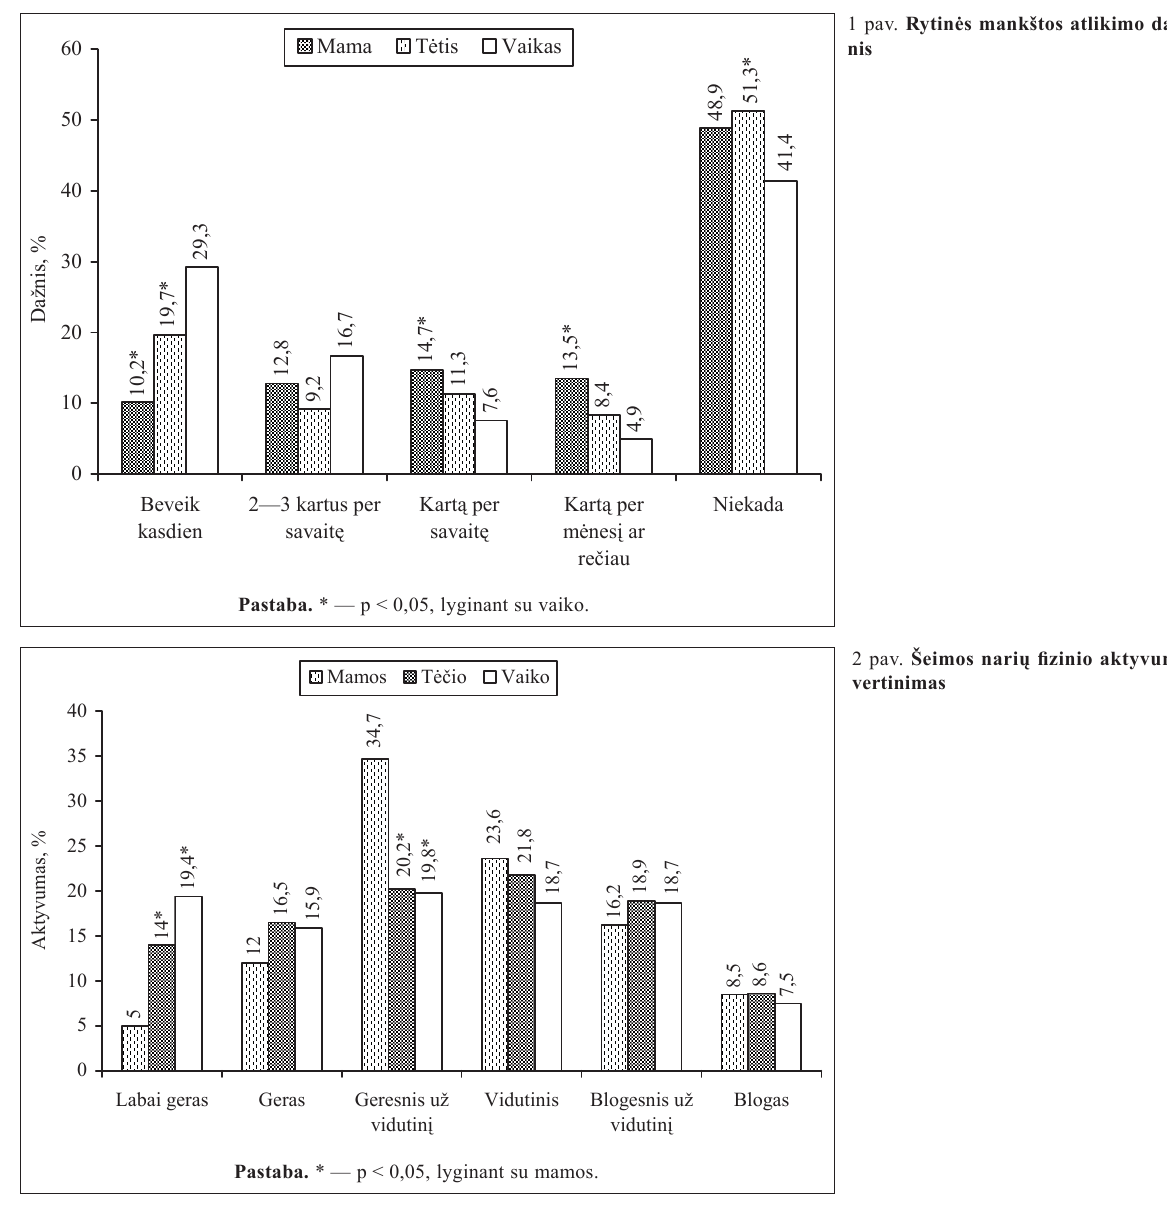
daržoves valgo ne kasdien. Daugiau nei tre č dalis mam ų su žemiausiu išsilavinimu atsak ė , kad j ų vai- kai daržoves valgo ne kasdien, t. y. pastebima ten- dencija — vaiko švieži ų daržovi ų valgymo dažnis susij ę s su motinos išsilavinimo did ė jimu (3 lent.). Analogiški duomenys gauti analizuojant vaik ų švieži ų vaisi ų vartojimo dažn į ir motinos išsilavi- nim ą . Pastebima tendencija, kad dažniau švieži vaisiai yra vartojami tose šeimose, kuriose mo- tinos išsilavinimas aukštesnis. Ir atvirkš č iai, kuo žemesnis išsilavinimas, tuo re č iau vaikai valgo švieži ų vaisi ų . Panaši tendencija nustatyta ir lygi- nant t ėč io išsilavinim ą su vaiko švieži ų vaisi ų ar daržovi ų vartojimu.